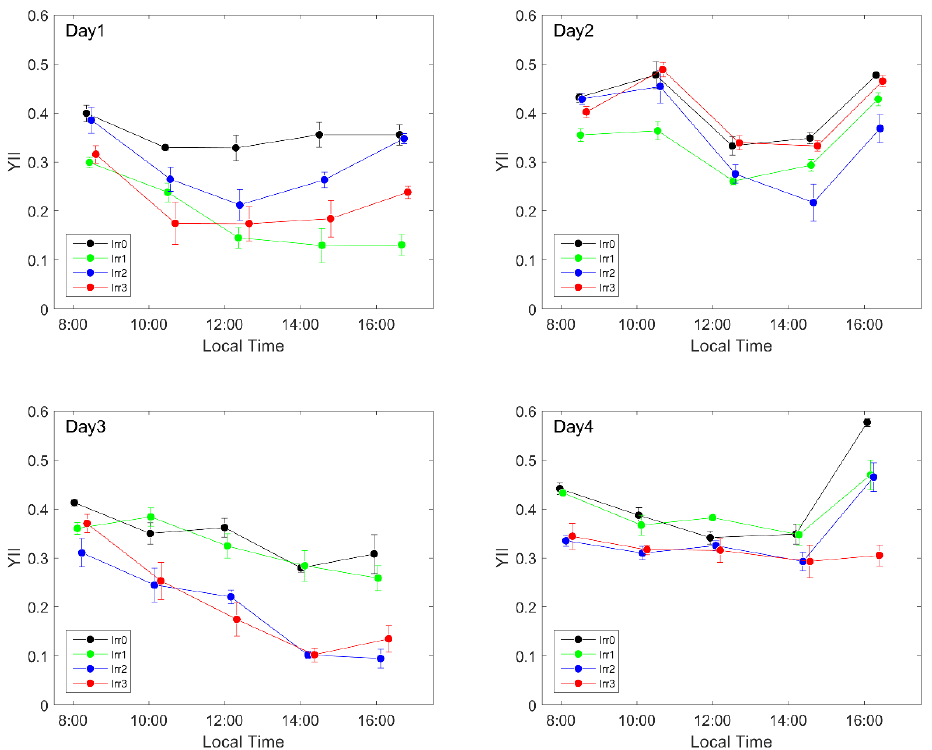
Figure 9. Diurnal variations in photosystem II operating efficiency ( YII) during the experiment, with Day1 to Day4 representing the four observation dates (30 July, 31 July, 3 August, 4 August, respectively).